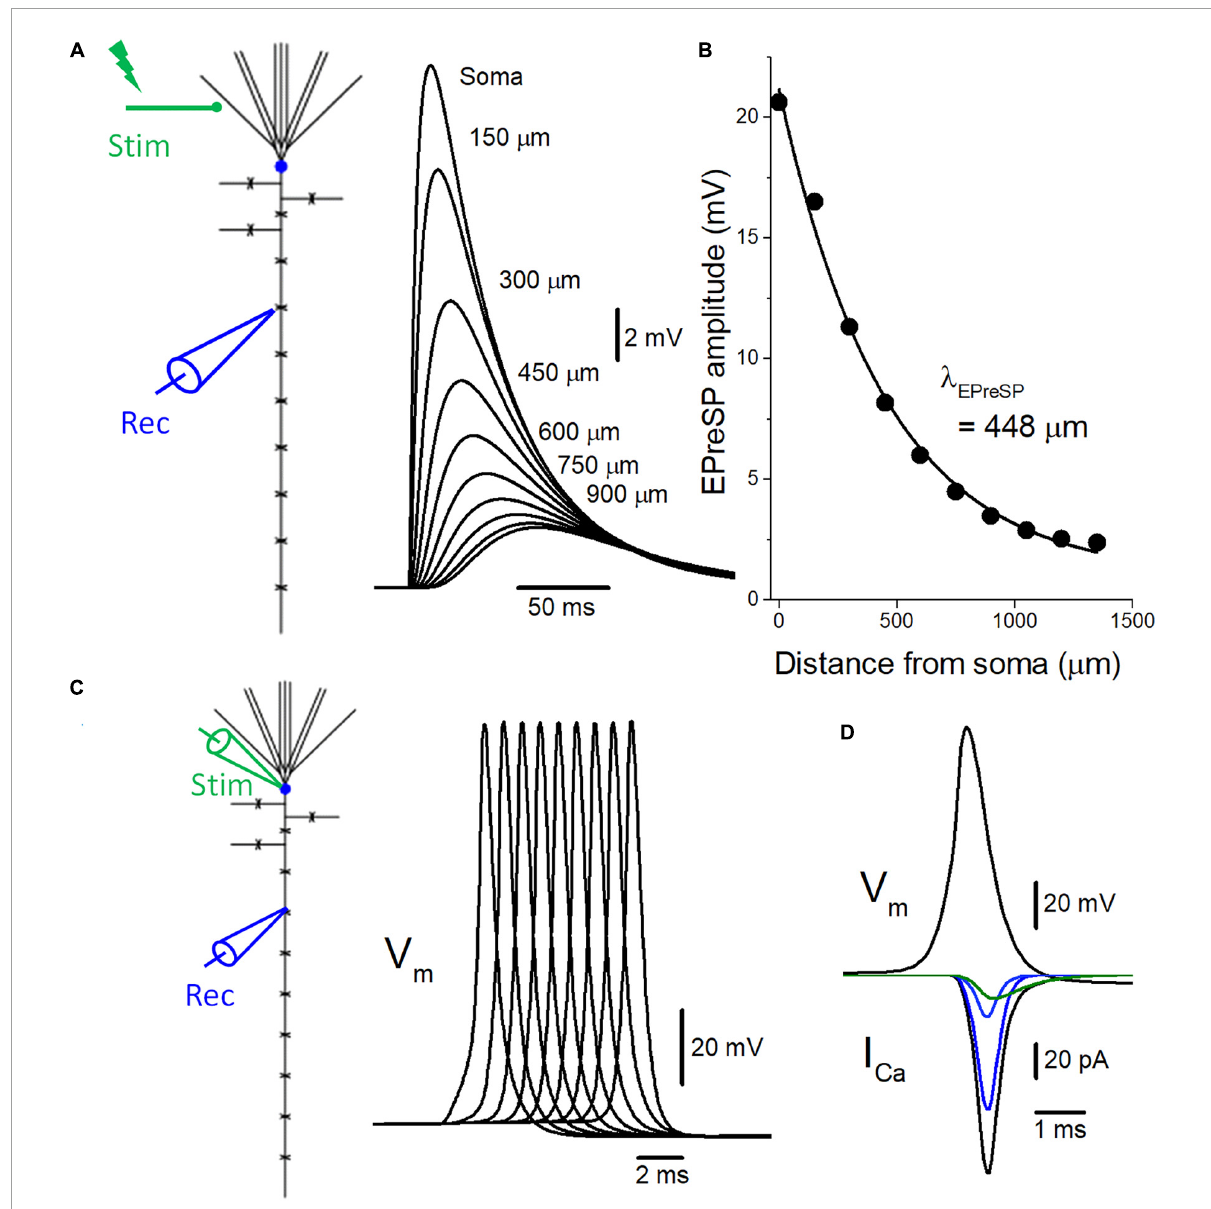
FIGURE2 Introduction of active conductance to the passive model of voltage signaling along the mossy fiber axon. (A) The multi-compartment model of granule cell was reconstructed according to the previous study (Alle and Geiger, 2006). Somatic depolarization, as well as EPreSPs at the mossy fiber boutons evenly spaced every 150 µ m along the main axons elicited by subthreshold dendritic synaptic input, are superimposed. (B) The peak amplitudes of EPreSPs are plotted against the distance from the soma. The fitted curve with single exponential decay shows a similar constant λ EPreSP = 448 µ m to those obtained in the previous experimental study. (C) Propagation of action potentials (V m : upper) throughout en passant axon with 9 boutons evenly spaced every 150 µ m following stimulation at the soma. (D) Simulated propagating action potentials at the mossy fiber bouton (V m : upper) and presynaptic Ca 2 + currents (I Ca : lower) during the action potentials. Total presynaptic calcium current (I Ca : black) consists of the components representing the sum of P/Q- (dark blue), N- (blue), and R-type (green) calcium